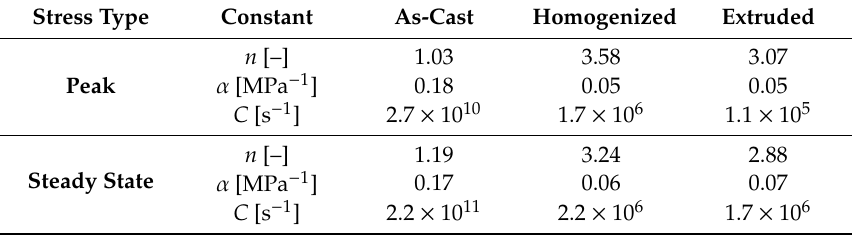
Table 4. Constants in Equation (5) calculated for the individual initial structural states.